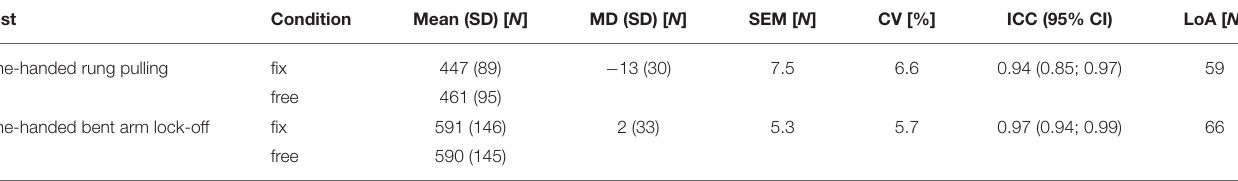
TABLE 3 | Comparison of the two conditions (free vs . fixed): validity and reliability indicators for both testing positions, measurements recorded by the Kistler force plate.